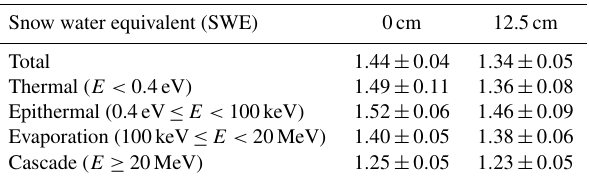
Table 1. Ratio of neutron flux for horizontal geometry to that for slanted geometry (slant angle 45 ◦ ), with 1 σ standard deviation of the Monte Carlo calculation.